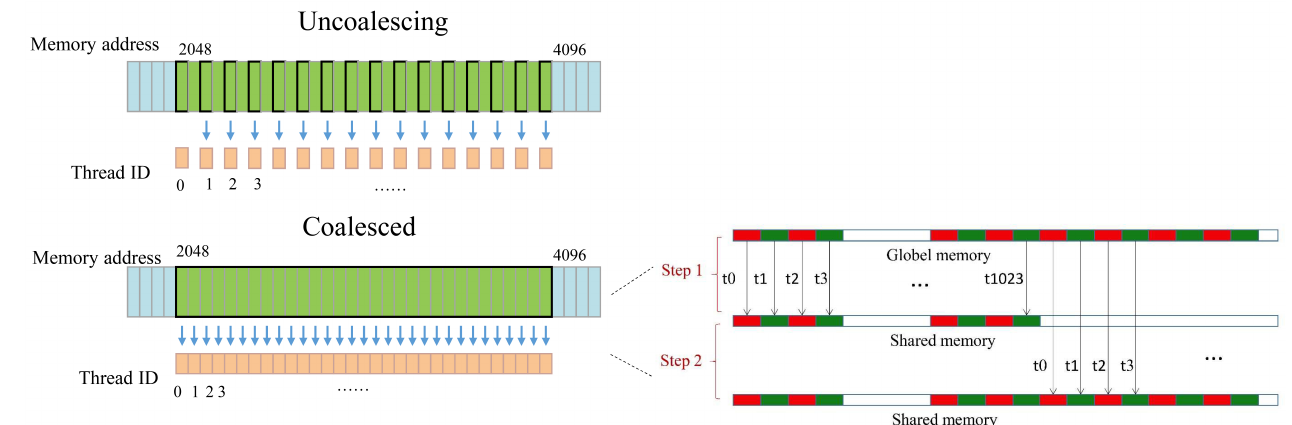
Figure 6. The uncoalescing problem and the corresponding